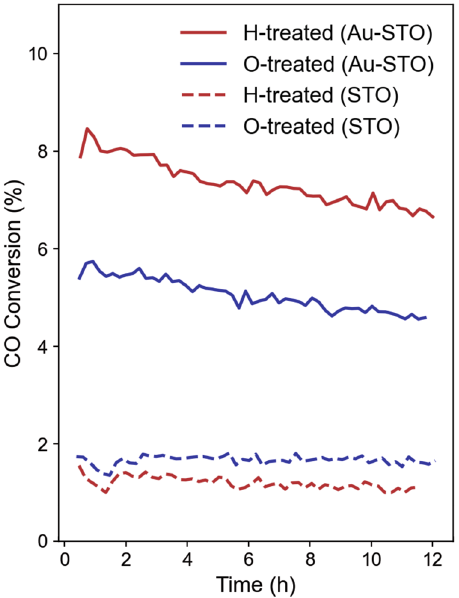
Fig. 6 Effect of catalyst charge state on performance. H-treated catalyst has increased CO conversion performance over O-treated catalyst (solid lines). Dashed lines indicate the performance of the STO substrate without Au catalyst particles, treated with the same procedures as the Au-STO